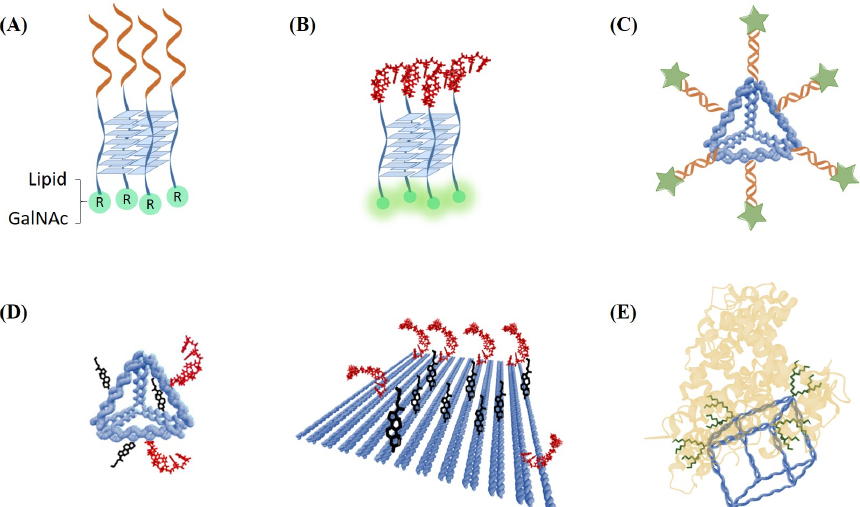
Figure 8. Schemes of DNA nanostructures carrying multifunctional ligands to improve drug delivery. ( A ) G-quadruplex functionalized with ASOs and hydrophobic groups [202,203], ( B ) G-quadruplex functionalized with FdU n oligomers [204], ( C ) DNA tetrahedron with four siRNAs carrying folic acid [205], ( D ) DNA tetrahedron and DNA origami functionalized with cholesterol moieties to deliver floxuridine [206], and ( E ) DNA cube with oligonucleotides carrying dendritic alkyl chains being able to modulate the affinity to human serum albumin [207].